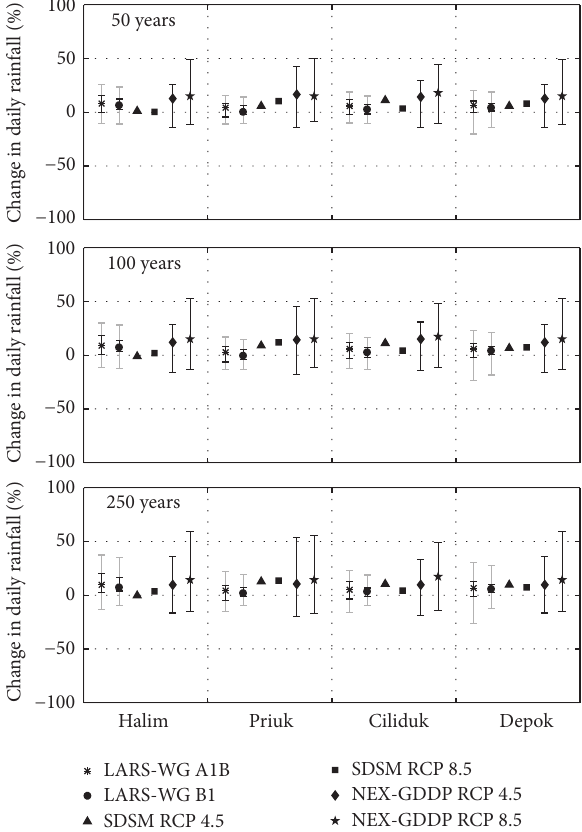
Figure 11: Comparison of percentage change in the annual maxi- mum daily rainfall for future time period using LARS-WG (2046– 2065), SDSM (2046–2068), and NEX-GDDP (2041–2070) with different emission scenarios. Dark vertical bars denote 10th and 90th percentile values for all GCMs which for LARS-WG is for the medians from 100 realizations for each of the GCMs. The light vertical bars for LARS-WG denote 10th and 90th percentiles obtained by pooling 100 realizations across all GCMs.